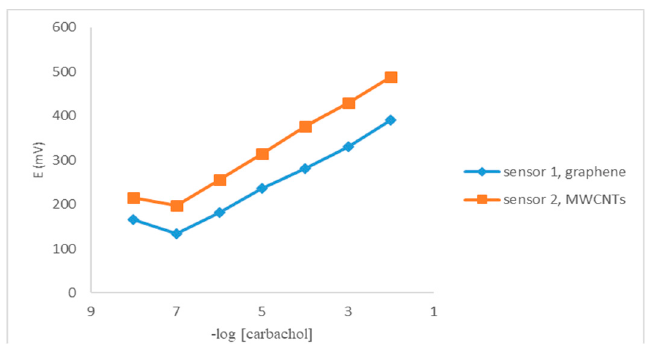
− log [carbachol] using the proposed sensors.